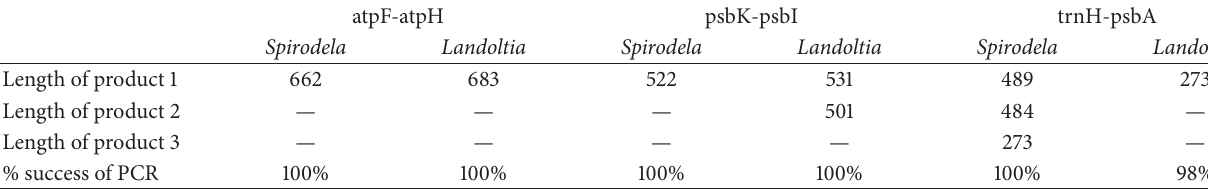
Table 3: Success ratios of PCR amplification and sequencing results of three pairs of designed markers. atpF-atpH psbK-psbI trnH-psbA Spirodela Landoltia Spirodela Landoltia Spirodela Landoltia